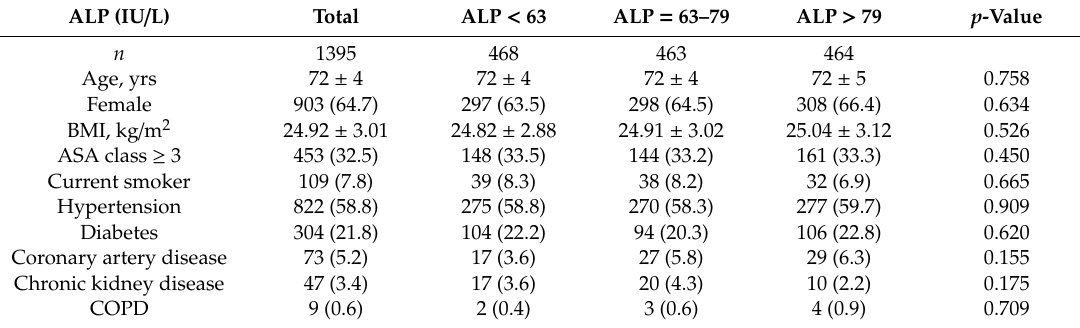
Table 1. Intergroup comparison of patient characteristics based on distribution of preoperative serum alkaline phosphatase levels into tertiles. Values are mean (SD), median (IQR (range)), or numbers